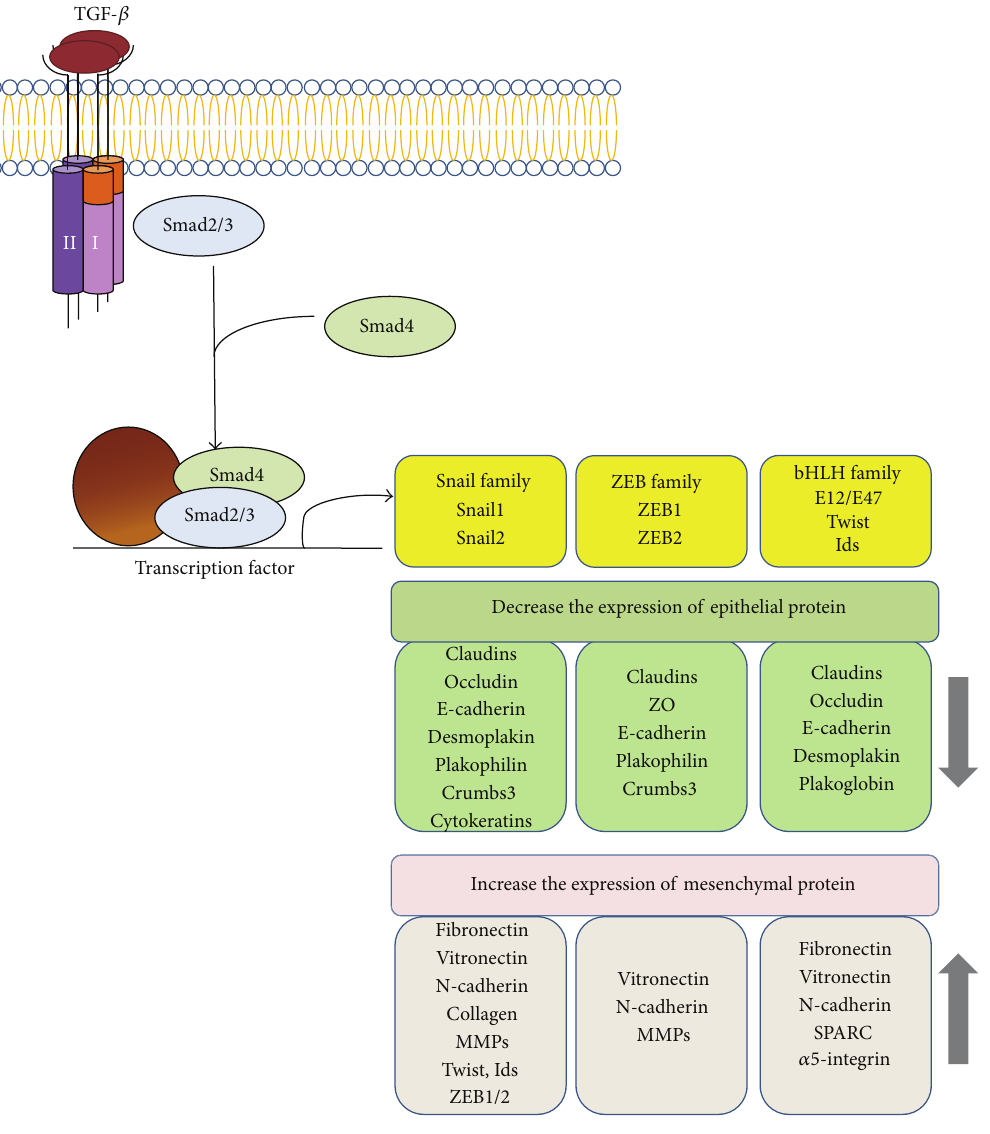
Figure 2: Transcriptional regulation of EMT induced by TGF- 𝛽 (according to Xu et al. [94]). In response to TGF- 𝛽 , Smad2 and Smad3 are activated to form complexes with Smad4, which then regulate the transcription of target genes through interactions with other DNA binding transcription factors. In the induction of EMT, the activated Smads mediate transcriptional regulation through three families of transcription factors, which results in repression of epithelial marker gene expression and activation of mesenchymal gene